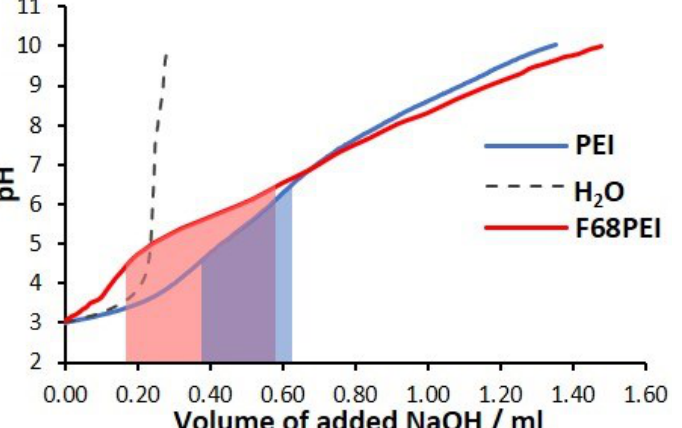
Figure 2. Buffering capacity of F68PEI and bPEI1.8k determined by titration with NaOH (0.1 M) within the range of pH 3–10. Colored inserts under the titration curves indicate NaOH volume needed to increase pH from 4.5 to 6.5, which is the physiological pH range of the endosomal system from lysosomes (pH 4.5) to early endosomal compartment (pH 6.5), in addition to indicating the buffering capacity, which is relevant for endosomal escape according to the “proton sponge” theor y.